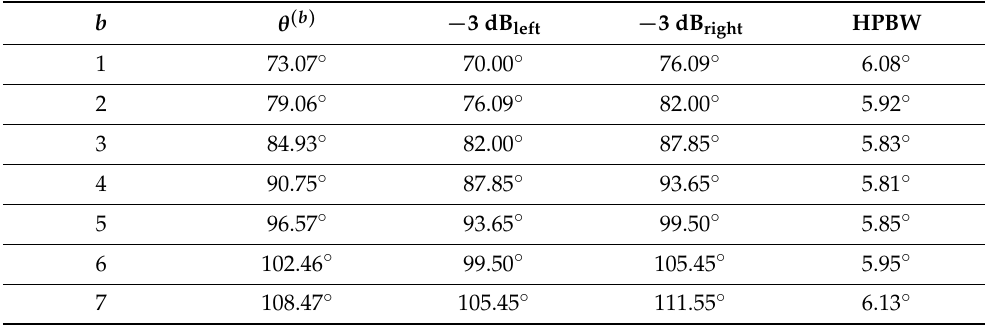
Table 1. Numerical Assessment (FP-CPA, I = 22, d = λ with respect to the θ (cid:48)